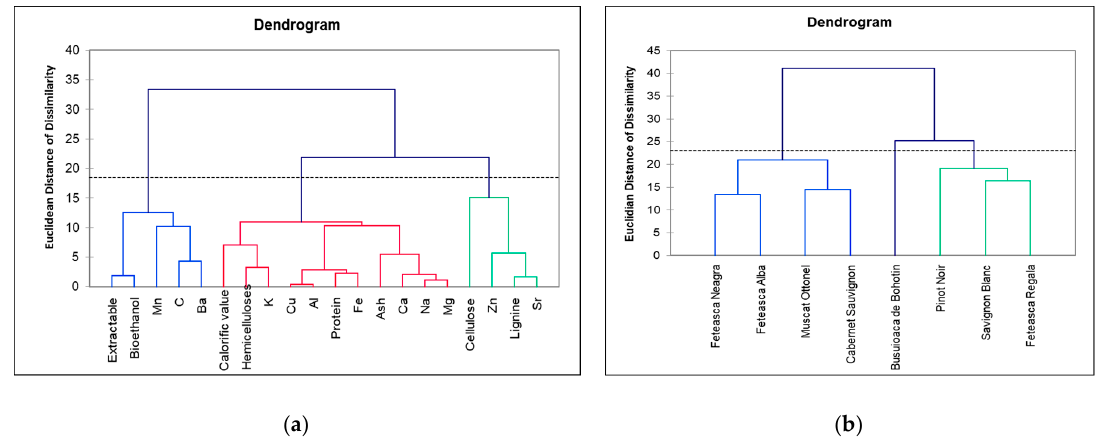
Figure 11. Hierarchical clustering (dendrogram) of ( a ) different components of vine-shoot waste ( b ) vine-shoot waste varieties.